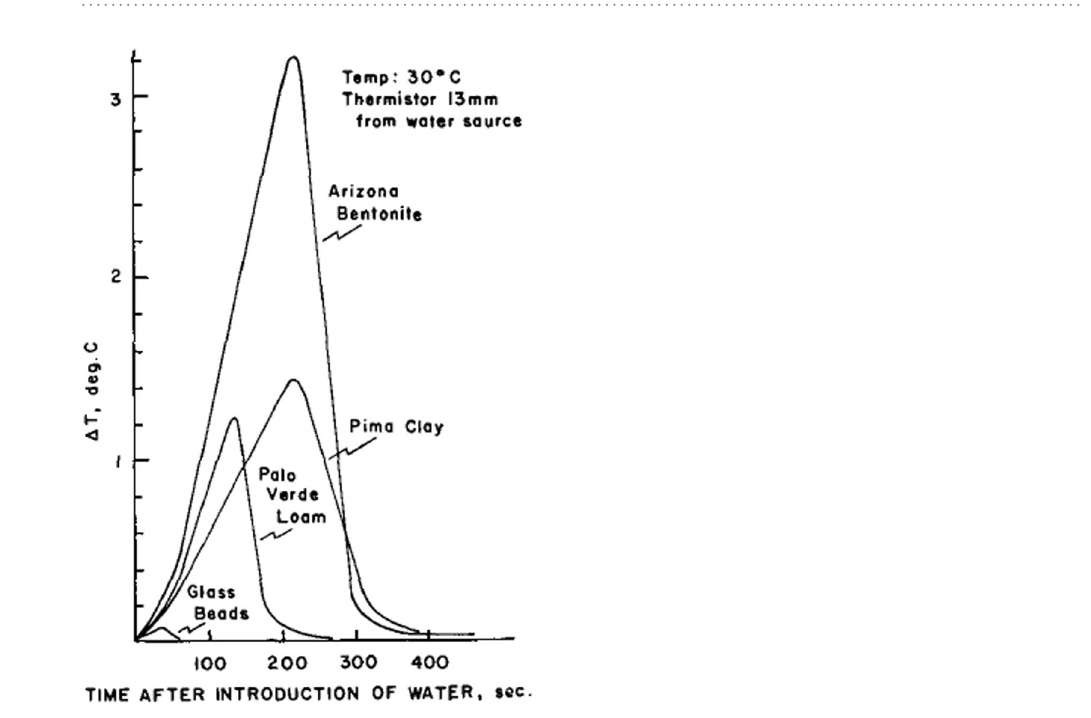
Figure 4. Temperature spikes observed for different types of porous medium (from Anderson and Linville) 6